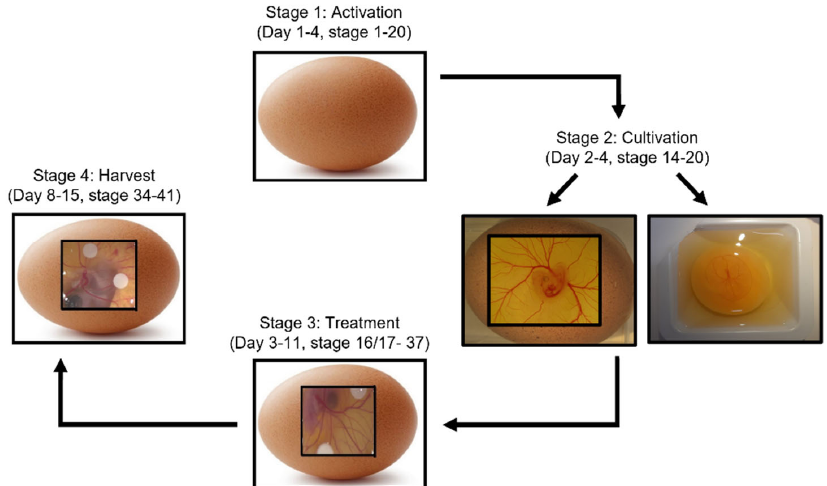
Figure 2. Schematic of four ‐ stage CAM assay process, along with approximate embryonic develop ‐